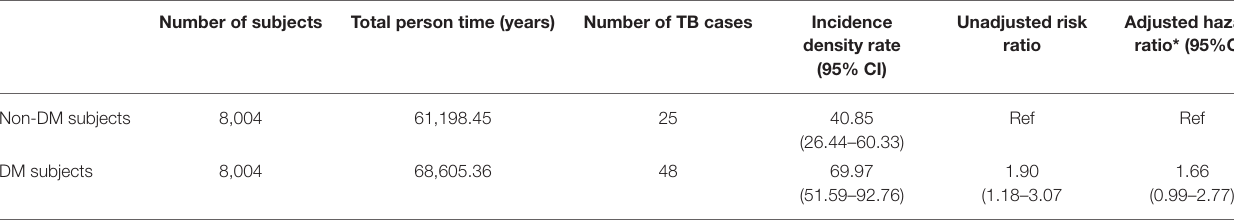
TABLE 2 | Incidence of tuberculosis in diabetic and non-diabetic subjects.